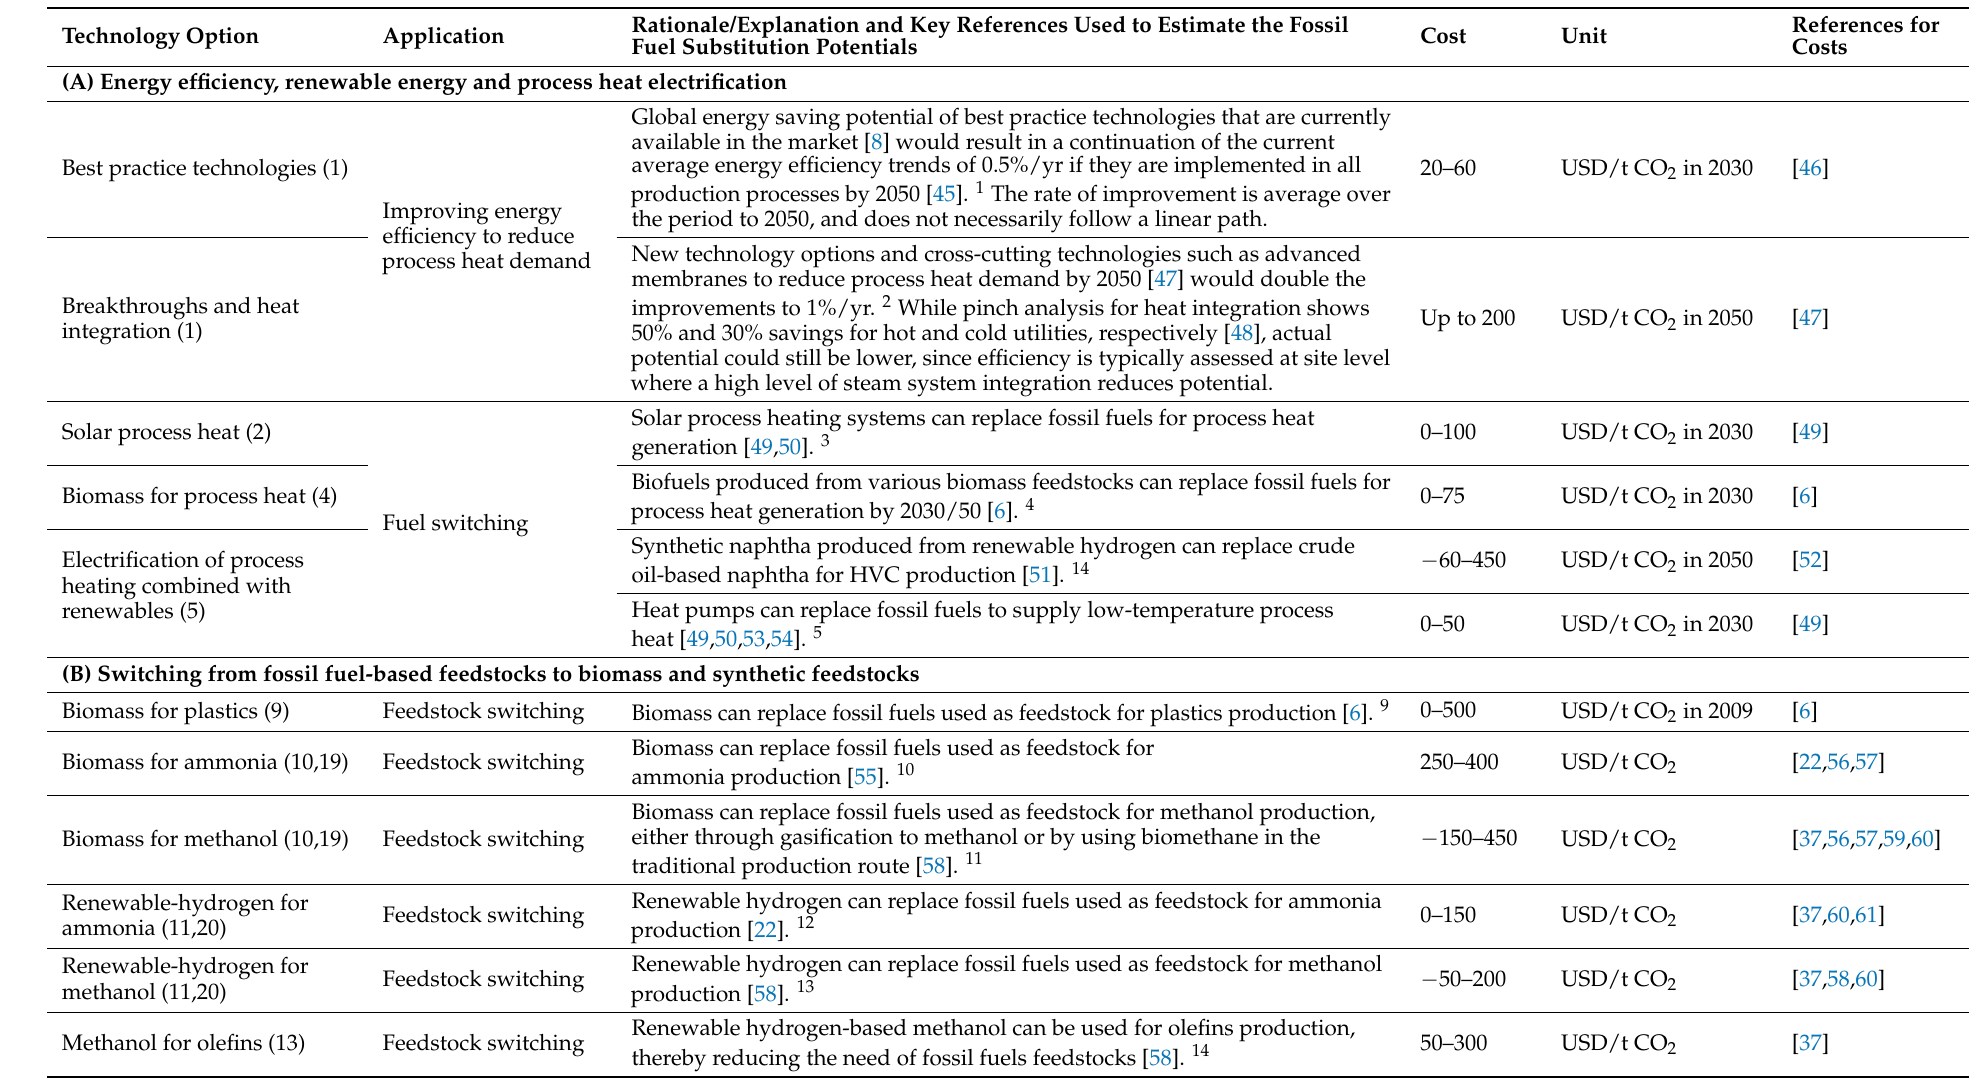
Table 3. Technology options covered in the